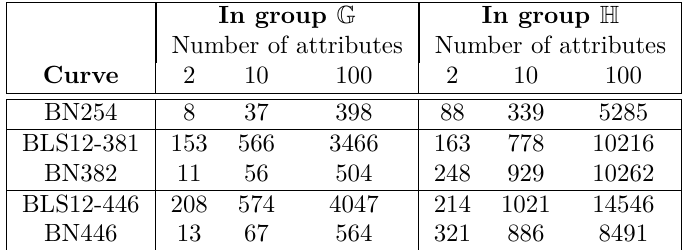
Table 5: The computational costs of _mul_sim_lot on the curves in 10 3 cycles, where the exponents are the coefficients ε j associated with the j -th